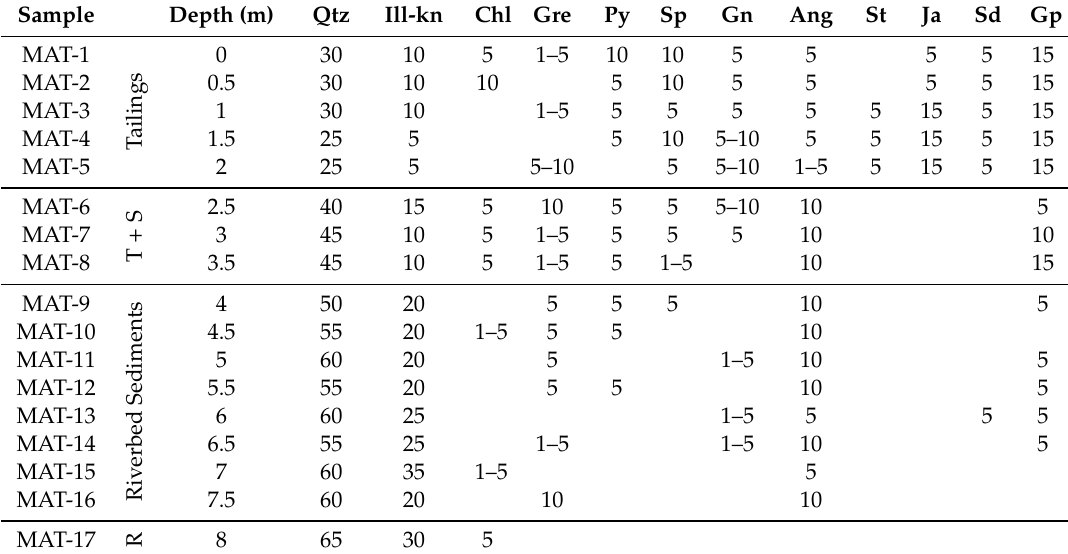
Table 1. Semi-Quantitative Mineralogical Composition (wt %) of the Studied Samples from the